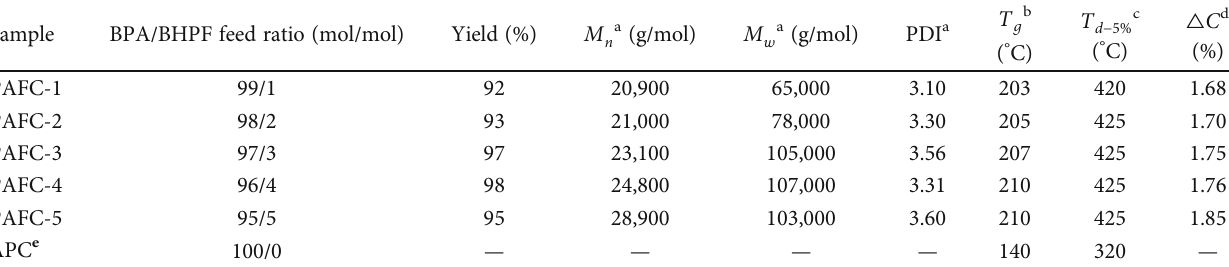
Table 2: Results of copolycondensation of BPA and BHPF with DPC.